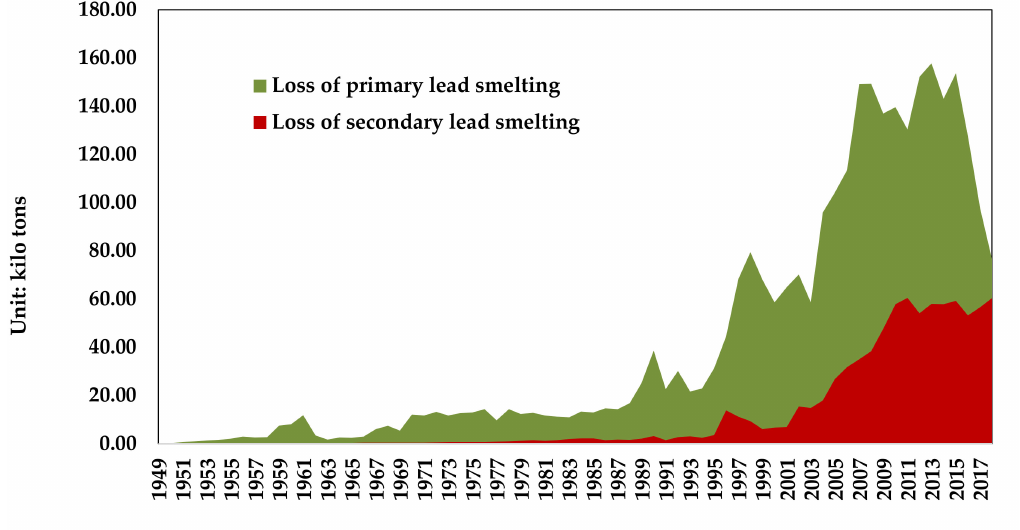
Figure 3. Lead material loss in lead smelting stage in China from 1949 to 2017. (Data source: [3,23]).